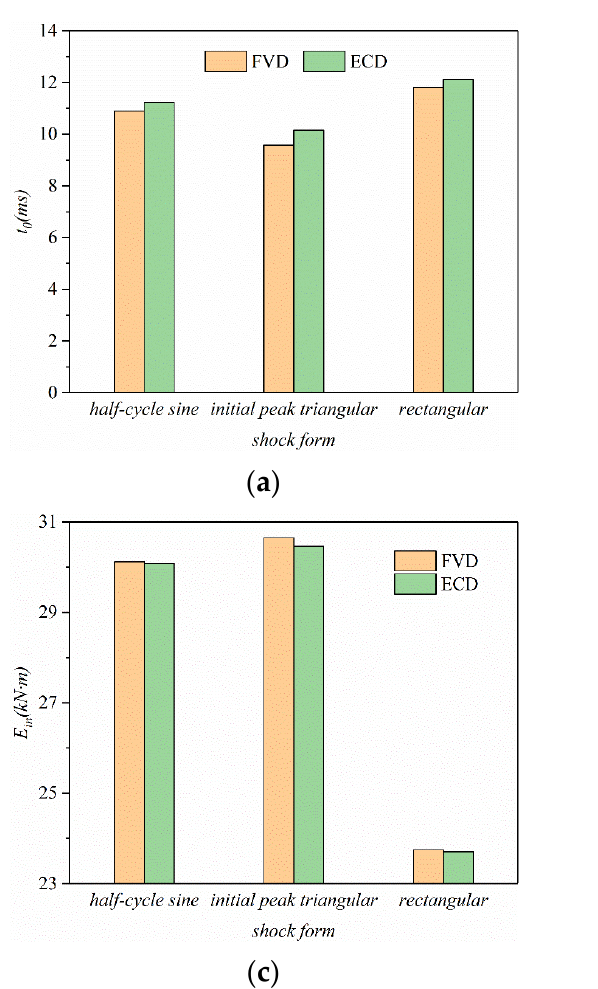
Figure 7. Comparison of the responses of the SDOF system with the FVD or the ECD: ( a ) Time of the target maximum displacement; ( b ) Time required for decaying to one-third of the target maximum displacement; ( c ) Energy input from the external loading; and ( d ) Energy dissipation by the damper.